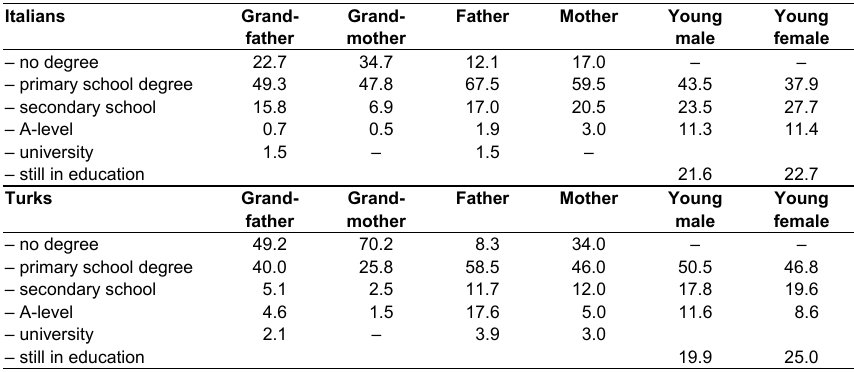
Table 8: Highest educational degree of Italians and Turks in intergenerational comparison